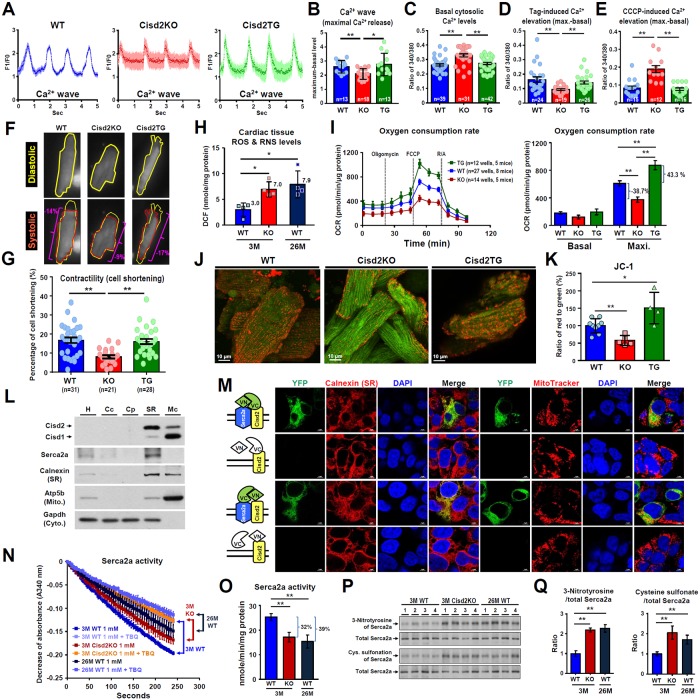
Cisd2 deficiency disrupts Ca2+ homeostasis via a dysregulation of Serca2a activity and this then results in mitochondrial Ca2+ overload and dysfunction in cardiomyocytes.(A and B) Spontaneous Ca2+ waves of beating cardiomyocytes isolated from WT, Cisd2KO, and Cisd2TG mice at 3M were measured by confocal microscopy (100 measures per second) using Fluo-4 AM staining. (A) The Ca2+ waves (F1/F0: fluorescence-intensity change normalized against the background fluorescence). Representative videos are provided in the supplemental information. (B) Quantification of maximal Ca2+ release (maximum-basal level). The data are presented as mean ± SD for 13–18 cells from 3–5 mice of each genotype. (C-E) The levels of cytosolic Ca2+ in single adult cardiomyocytes isolated from WT, Cisd2KO, and Cisd2TG mice were measured by fluorescence microscopy using Fura-2/AM staining. After measuring the basal level of cytosolic Ca2+ (first 50 seconds), Tag was added to release Ca2+ from the SR. Alternatively, CCCP was added to release Ca2+ from the mitochondria. Quantification of the basal cytosolic Ca2+ levels (C), Tag-induced Ca2+ elevation from the SR (D), and CCCP-induced Ca2+ elevation from mitochondria (E) of the adult cardiomyocytes. The data are presented as mean ± SEM for 12–42 cells from 5–6 mice of each genotype. (F) Contractility (cell shortening) was measured during the spontaneous beating of cardiomyocytes (representative videos are provided in the supplemental information). (G) Quantification of cell shortening for 21–31 cells from 5–6 mice of each genotype. The data are presented as mean ± SEM. (H) Quantification of ROS and RNS levels in the heart by measuring DCF levels using cardiac tissue samples (n = 4 for each group). The data are presented as mean ± SD. (I) OCRs of the isolated adult cardiomyocytes from different genotypes. The indicated chemicals (oligomycin A, FCCP, R/A) were added sequentially to determine the ATP-coupled respiration rate, the maximal respiration rate (Max), and the nonmitochondrial respiration rate, respectively, using a Seahorse XFe24 analyzer. (J and K) Representative confocal microscopic pictures (J) and quantification of JC-1 flowcytometric staining results (K), which were used to measure the mitochondrial membrane potential of adult cardiomyocytes isolated from WT, Cisd2KO, and Cisd2TG mice. (L) Western blot analysis of Cisd2, Serca2, Calnexin (SR), Atp5b (mitochondria), and Gapdh (cytosol) using different subcellular fractions prepared from the hearts of WT mice. A total of 10 μg of protein from each fraction was loaded. (M) Bimolecular fluorescence complementation assay using split-YFP constructs of Cisd2 and Serca2a. Cisd2 and Serca2a were fused with the C-terminal (VC) or N-terminal (VN) domain of the YFP protein and transfected into HEK-293T cells. The localization of the refolded Venus protein (green), SR (red) or mitochondria (red), and the cell nucleus (blue) are detected by confocal microscopy. Scale bar, 5 μm. (N) Serca2a (Ca2+-ATPase) activity was measured as the decrease in the absorbance at 340 nm using heart tissue from the various genotypes. Specifically, Serca2a activity was measured by the activity difference between 1 mM CaCl2 with and without the Serca-specific inhibitor TBQ. (O) Quantification of the Serca2a activity in heart tissue (n = 3). The data are presented as mean ± SD. (P) Oxidative modifications involving 3-nitrotyrosine and cysteine sulfonation of Serca2a were assessed by IP of the Serca2a protein from heart tissue samples followed by western blot analysis using antibodies against 3-nitrotyrosine, cysteine sulfonate, and Serca2a. (Q) Quantification of oxidative modifications to Serca2a by 3-nitrotyrosine and cysteine sulfonation (n = 4). The data are presented as mean ± SD and are analyzed using Student t test. *p < 0.05; **p < 0.005. Values for each data point can be found in S1 Data. 3M, 3 months old; 26M, 26 months old; Cc, crude cytosolic fractions; CCCP, carbonyl cyanide m-chlorophenyl hydrazone; Cisd2, CDGSH iron-sulfur domain-containing protein 2; Cp, pure cytosolic fractions; DCF, 2′, 7′-dichlorofluorescein; FCCP, carbonyl cyanide p-trifluoromethoxyphenylhydrazone; Gapdh, glyceraldehyde 3-phosphate dehydrogenase; H, homogenates; IP, immunoprecipitation; KO, knockout; Mc, crude mitochondrial fraction; OCR, oxygen consumption rate; R/A, rotenone/antimycin A; RNS, reactive nitrogen species; ROS, reactive oxygen species; Serca, sarco/endoplasmic reticulum Ca2+-ATPase; SR, sarcoplasmic reticulum; Tag, thapsigargin; TBQ, 2,5-Di-tert-butylhydroquinone; TG, transgenic; WT, wild type; YFP, yellow fluorescent protein.